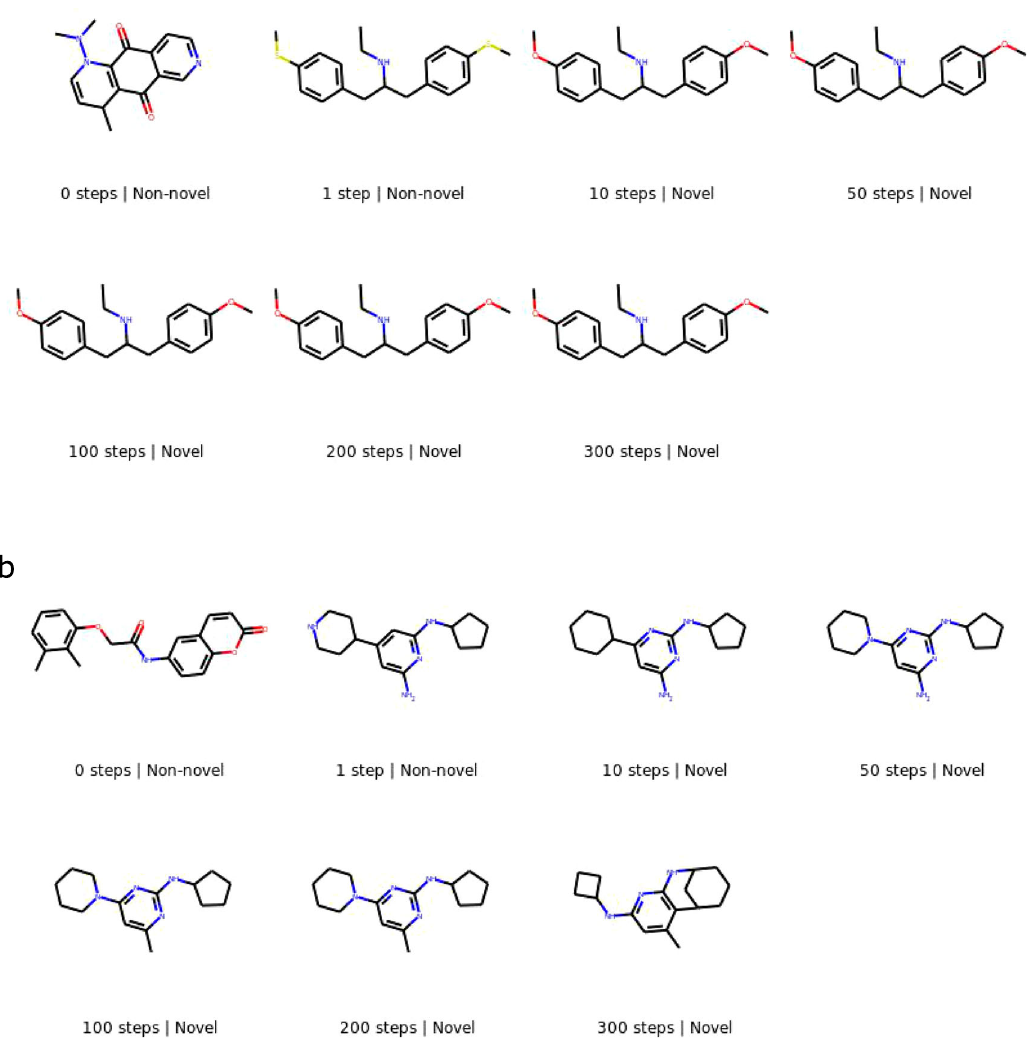
Fig. 3 Generation trajectory of a molecule each for a 1% and a 5% masking rate. The model is trained on ChEMBL, and generation is carried out using training initialization. a 1% masking rate. b 5% masking